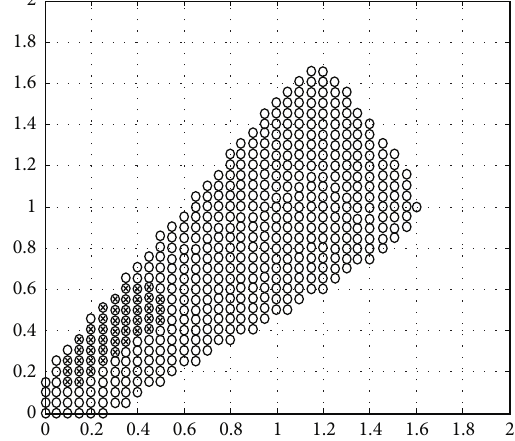
Figure 1: Stability region of Theorem 1 with ρ � 0 . 75 (denoted by “o”) and with ρ and ρ 3 � 0 . 85 (denoted by “ × ”). ρ 3